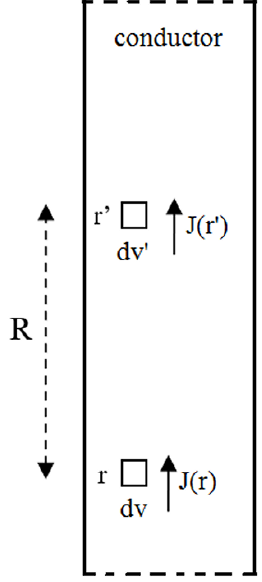
Figure 1. Inductance calculation according to Equation (3).